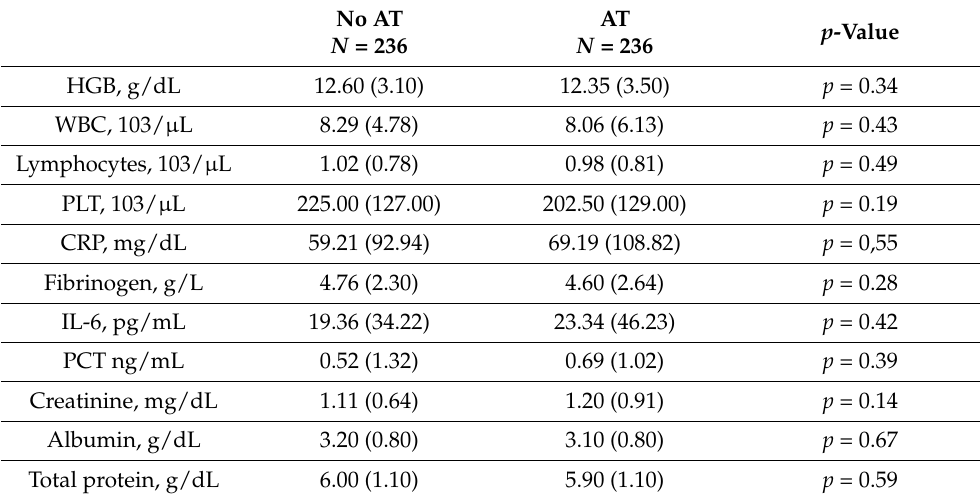
Table 3. Laboratory values in matched patients populations.